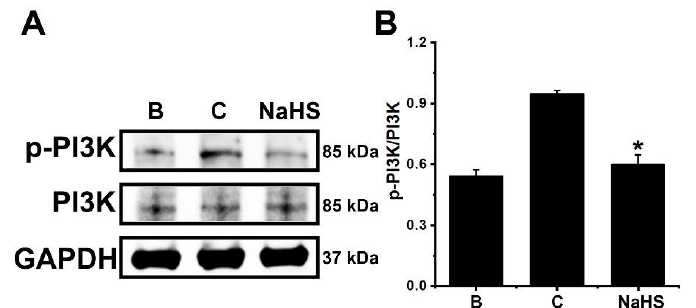
Figure 3. Inhibition of PI3K phosphorylation by NaHS in dHL-60 cells. ( A ) Cells (5 × 10 6 /mL) were pretreated with NaHS (1 mM) for 1 h, followed by GM-CSF-stimulation (5 ng/mL) for 15 min. ( B ) The protein levels were quantitated by densitometry. Blank (B) corresponds to PBS treated cells without GM-CSF stimulation, and control (C) corresponds to PBS treated cells stimulated by GM-CSF. Results are expressed as the mean ± SEM from three separate experiments. * p < 0.05, as compared with the PBS treated cells stimulated by